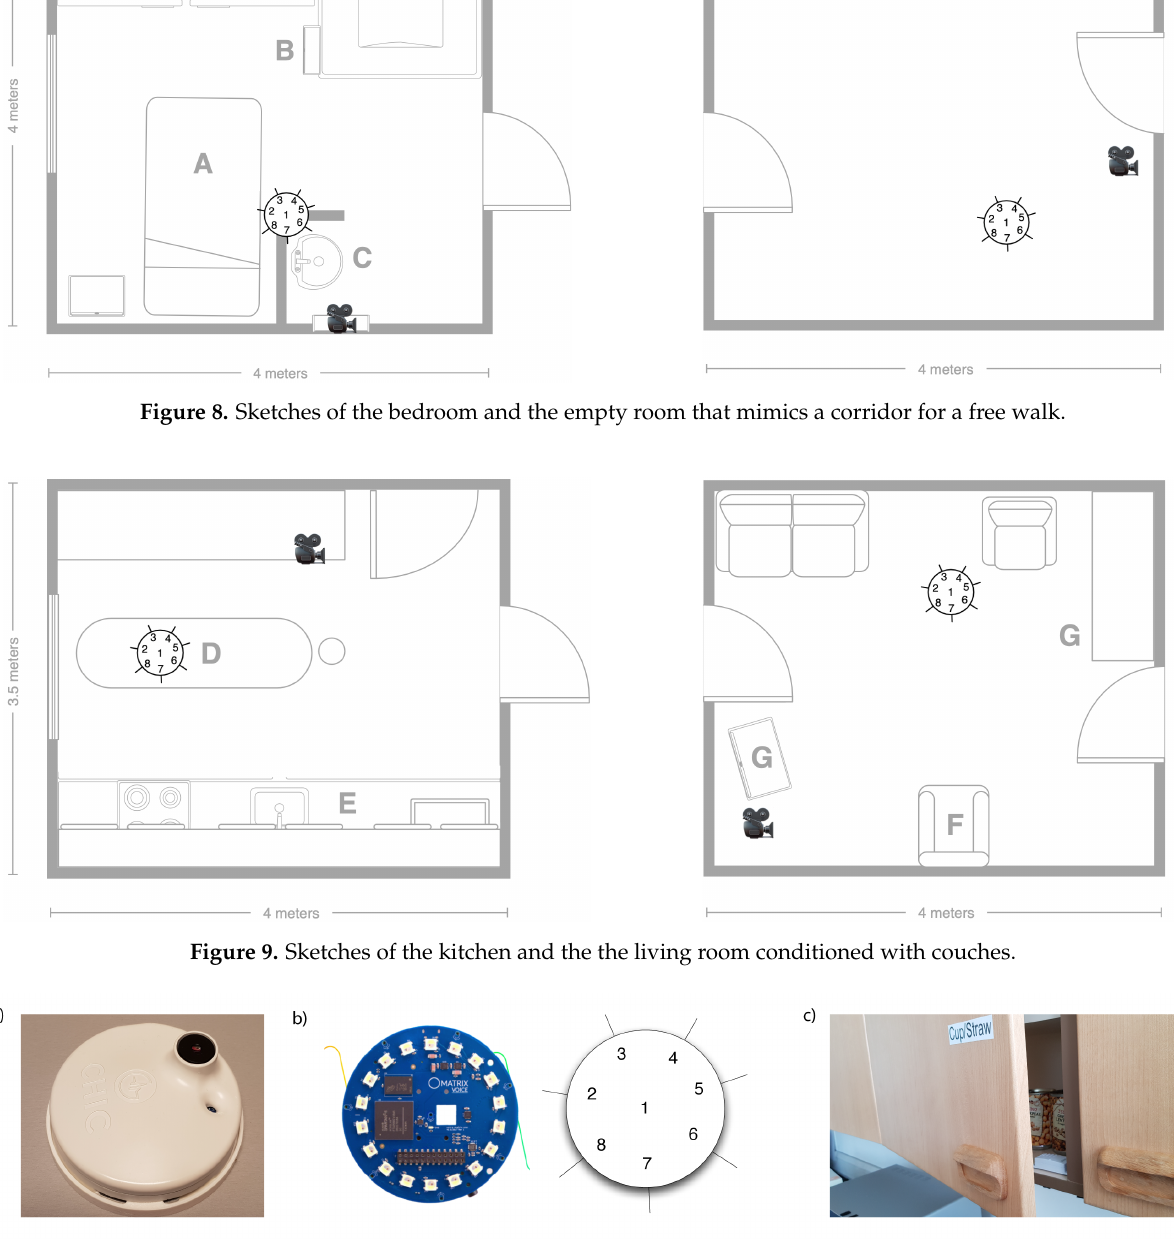
Figure 10. ( a ) TVS device, ( b ) matrix voice ESP32 ( left ), and location of embedded microphone ( right ) and ( c ) a cupboard depicting a binary